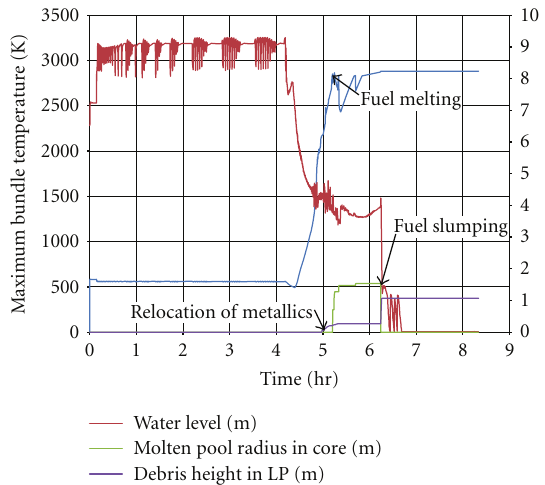
Figure 11: Maximum bundle temperature, water level, e ff ective molten pool radius, and lower plenum debris height for a scenario with depressurization and termination of emergency water injection at 4.2 hours after reactor scram (CRD flows maintained).